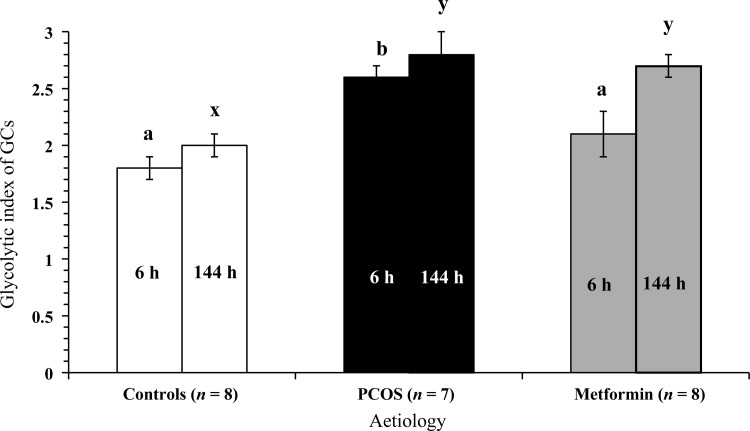
The effects of aetiology and duration of culture on the glycolytic index of GCs. The values plotted are mean ± SEM of the data for the number of individual patient cultures shown. a and b indicate significant difference (P < 0.05) between the aetiological groups at 6 h of culture (6 h) and x and y indicate significant difference (P < 0.05) between the aetiological groups at 144 h of culture (144 h).